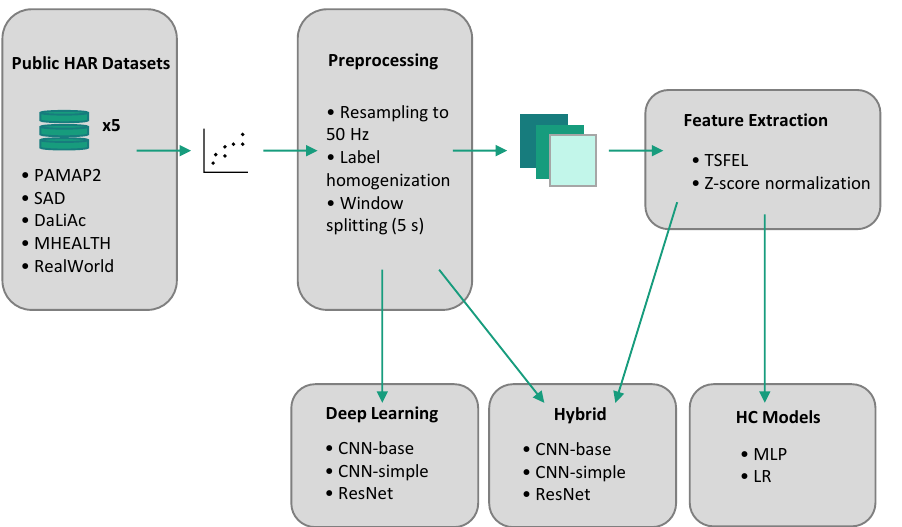
Figure 4. Scheme of the experimental